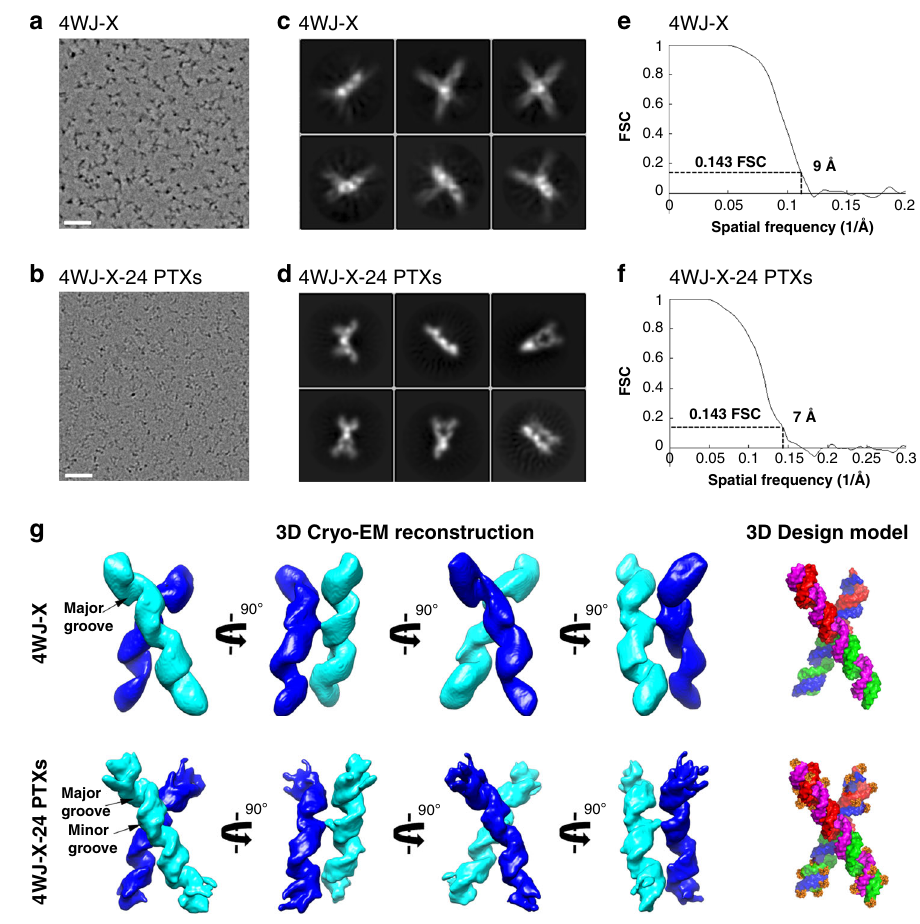
Fig. 3 Comparison of 4WJ-X and 4WJ-X-24 PTXs nanoparticles by single-particle cryo-EM. a Representative motion-corrected cryo-EM micrographs of 4WJ-X and b 4WJ-X-24 PTXs (scale bar: 500 Å). c Reference-free 2D class averages of 4WJ-X and d 4WJ-X-24 PTXs computed in Relion. e Gold standard Fourier shell correlation (FSC) plots to measure resolution at FSC = 0.143 for the 3D reconstruction of 4WJ-X and f 4WJ-X-24 PTXs. g 3D reconstructed cryo-EM maps of 4WJ-X and 4WJ-24 PTXs in four views, with a Supplementary Movie 1. A 3D design model is shown. Source data are provided as a Source Data fi